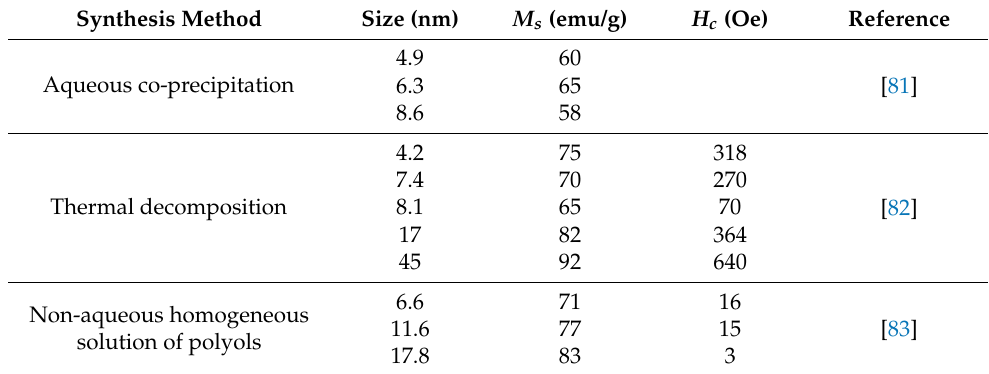
Table 2. Main magnetic properties of Fe 3 O 4 nanoparticles. Synthesis